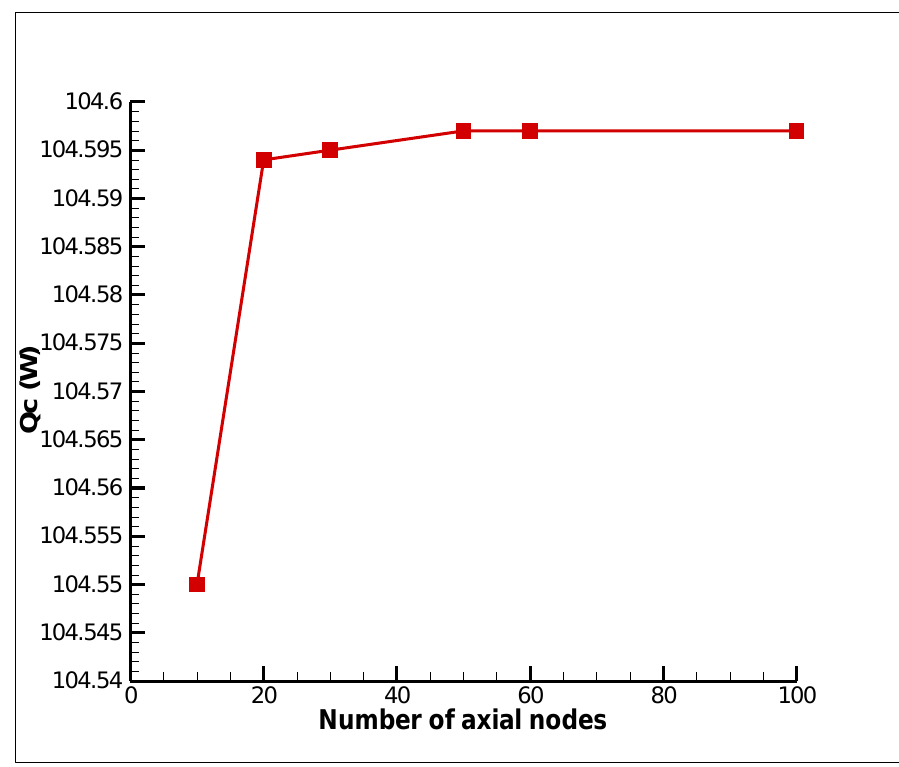
Figure 5. Independence of the results from the number of computational nodes.